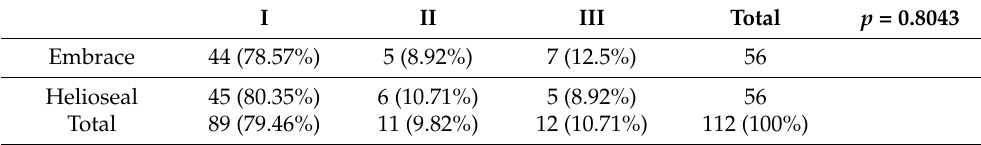
Table 4. Assessment of sealant retention after 24 months according to Simonsen’s criteria.